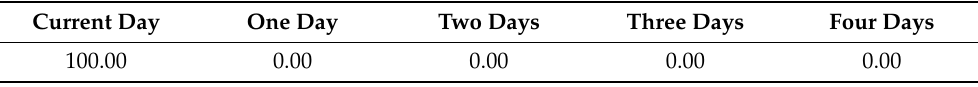
Table 9. Prediction results are based on ratio of R in RGB values with noise.